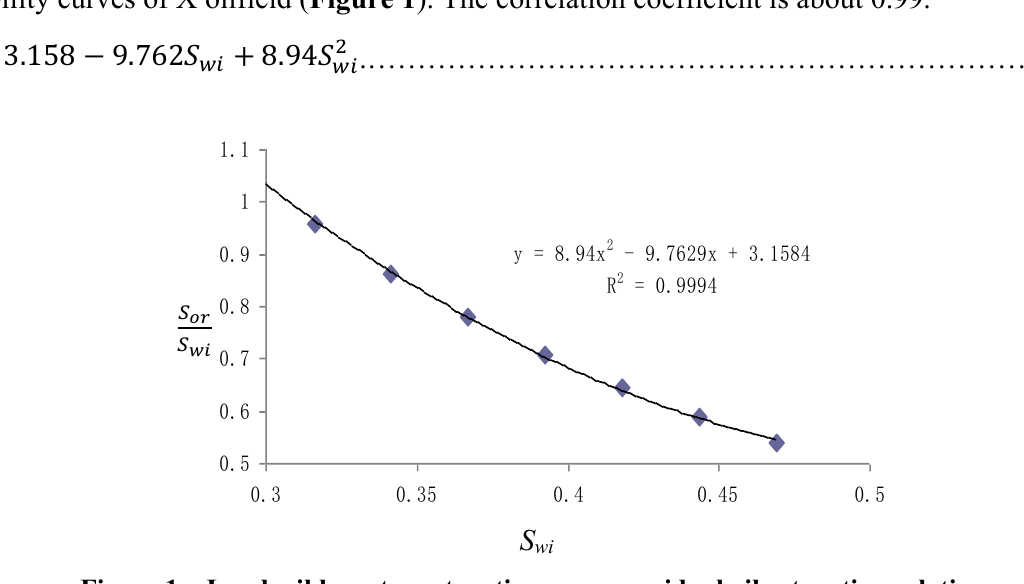
Figure 1—Irreducible water saturation versus residual oil saturation